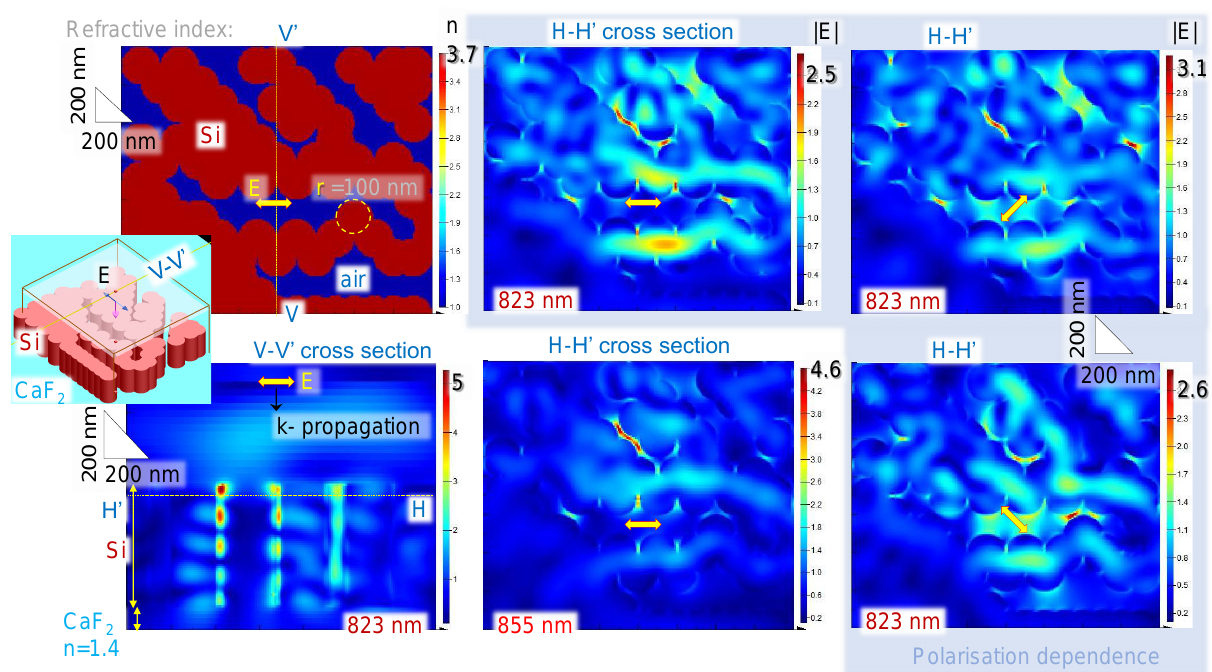
Figure 6. A numerical toy-model of light scattering and enhancement by an Si columnar pattern on CaF 2 for different orientations of incident linearly polarised E -field (0; ± π /4) of light calculated by a finite difference time domain (FDTD) solver (Lumerical). Transverse V’-V and longitudinal H’-H cross sections show ( E / E 0 ) field enhancement for the incident plane wave E 0 = 1. Height of r = 100 nm Si cylinders was 0.5 µ m; perfectly matching boundary conditions were used. Inset shows 3D rendering of the calculation volume. Permittivity of Si at the selected wavelength was used from the Palik’s database in